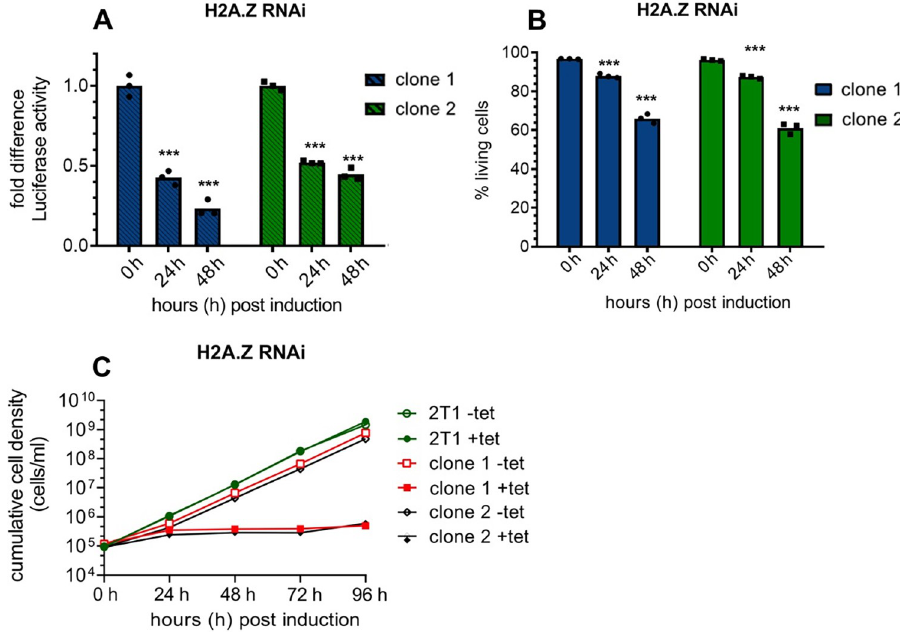
Fig 6. Depletion of the histone variant H2A.Z leads to a decreased luciferase activity within a PTU. A luciferase reporter construct was integrated into the tubulin array of a H2A.Z (Tb927.7.6360) RNAi cell line. Samples for the luciferase assay were normalised to cell numbers. (A) Luciferase activity was monitored for 48 h after induction of RNAi in two independent clones. Values of non-induced cells were set to 1; (N = 3); (B) Live/dead staining of each RNAi cell line was performed in triplicates at the same time points. (C) Growth of parasites was monitored for 96 hours (N = 3) after RNAi-mediated depletion of H2A.Z using tetracycline (tet) induction. Growth of the parental 2T1 cell line was measured for 96h as a control. (N = 3 for all depicted experiments; ��� = p-value < 0.001; �� = p-value 0.001–0.01; � = p-value 0.01–0.05).